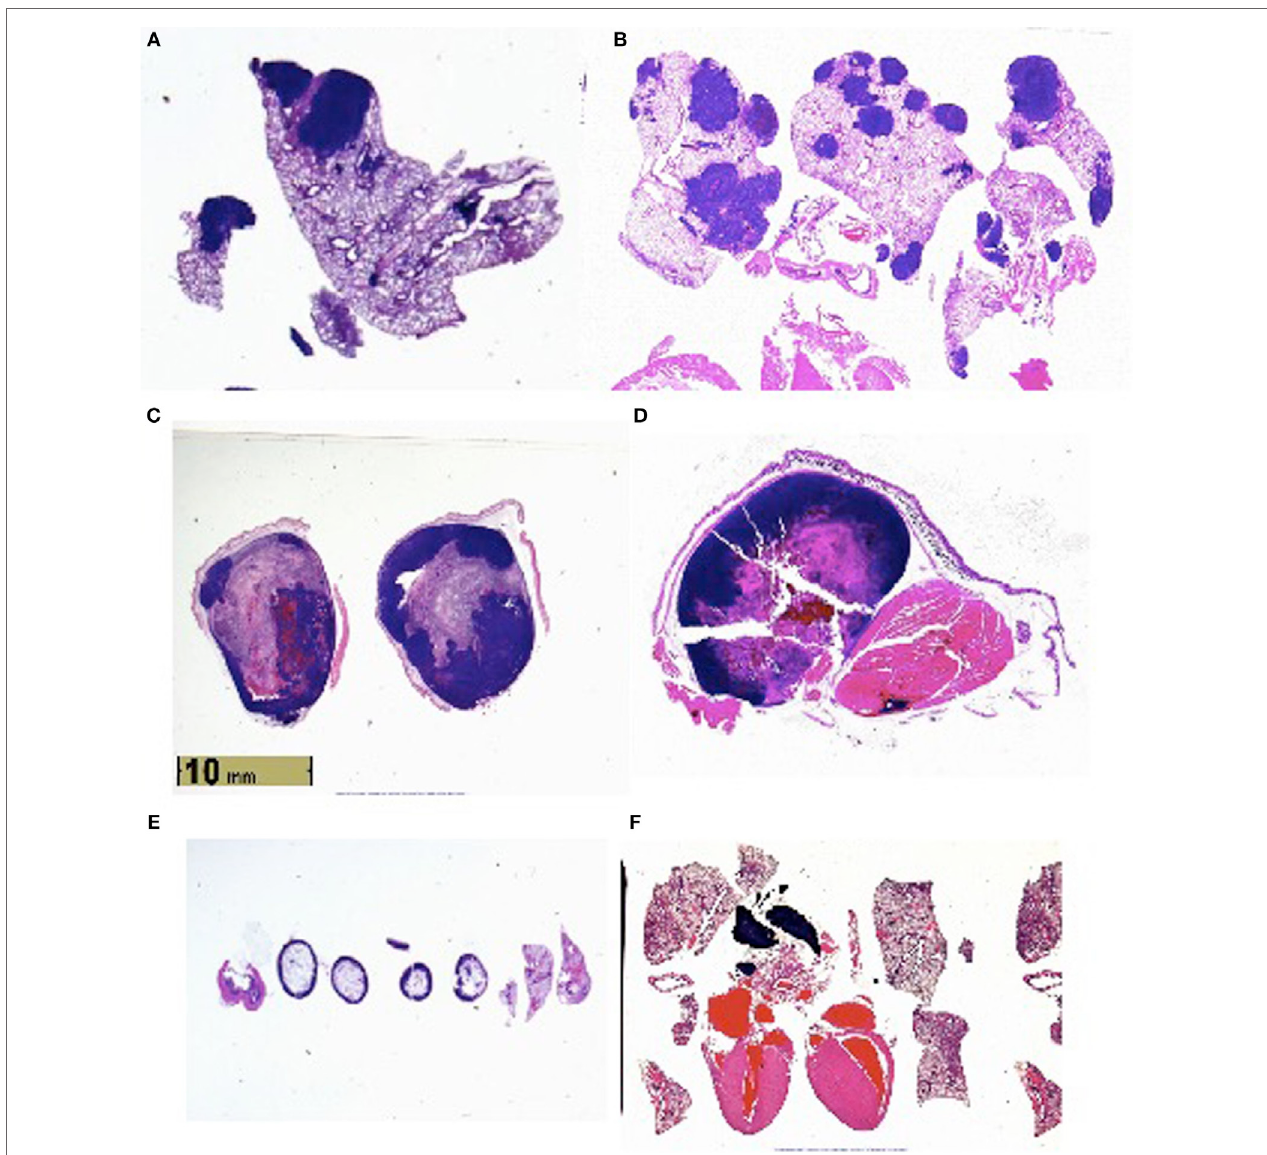
FigUre 1 | (a) Lung metastases in vasoactive intestinal peptide knockout (VIP KO) mouse. (B) Lung metastases in C57BL/6 mouse. (c) Leg tumor in VIP KO mouse. (D) Leg tumor of C57BL/6 mouse. (e) Histology of healthy VIP KO mouse, including lungs. (F) Histology of healthy C57BL/6 mouse, including heart and